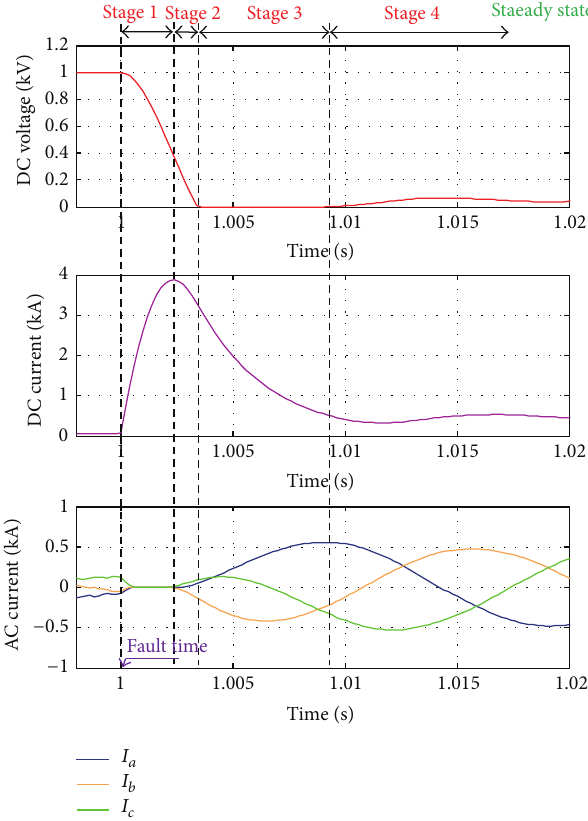
Figure 5: The fault characteristic diagram of the rectifier during DC short-circuit fault.